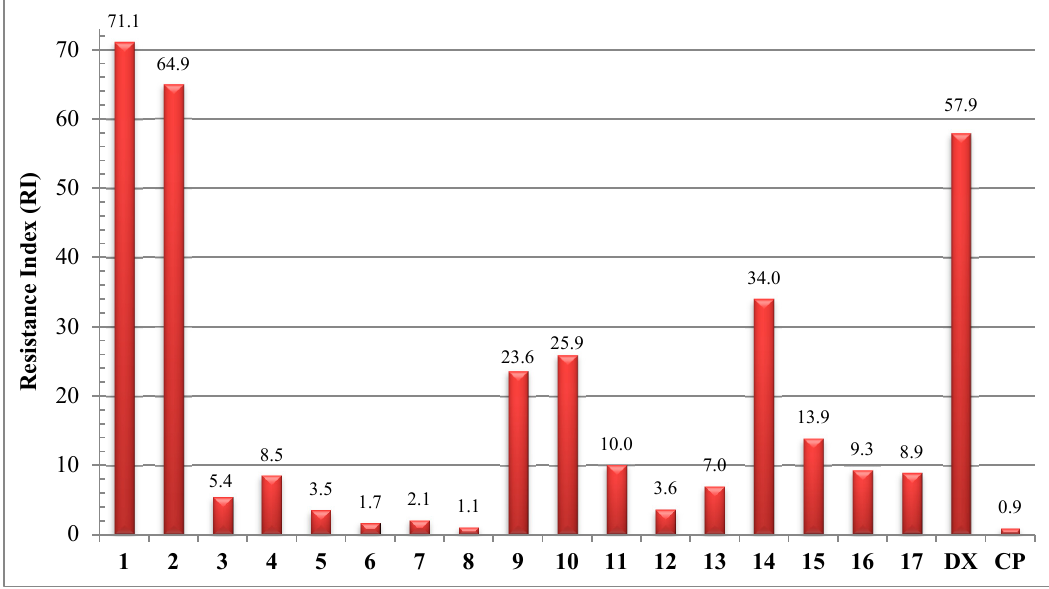
Figure 2. Comparison of resistance index (RI) values of tested compounds. RI indicates how many times more chemoresistant is a resistant subline relative to its parental cell line. The RI was calculated for each compound using the formula: RI = (IC 50 for LoVo/DX)/(IC 50 for LoVo) cell line. When RI is 0–2, the cells are sensitive to the compound tested, RI in the range 2–10 means that the cell shows moderate sensitivity to the drug tested, RI above 10 indicates strong drug resistance.